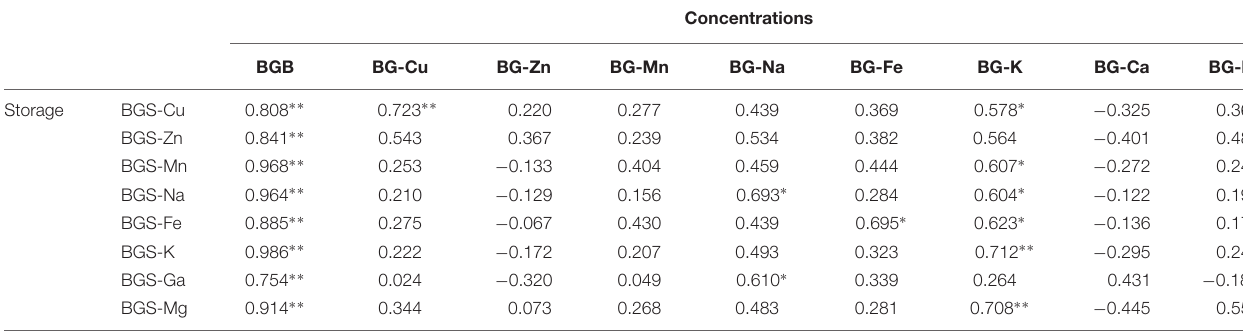
TABLE 4 | Correlation analysis between concentrations and storage in the belowground part of B. ischaemum